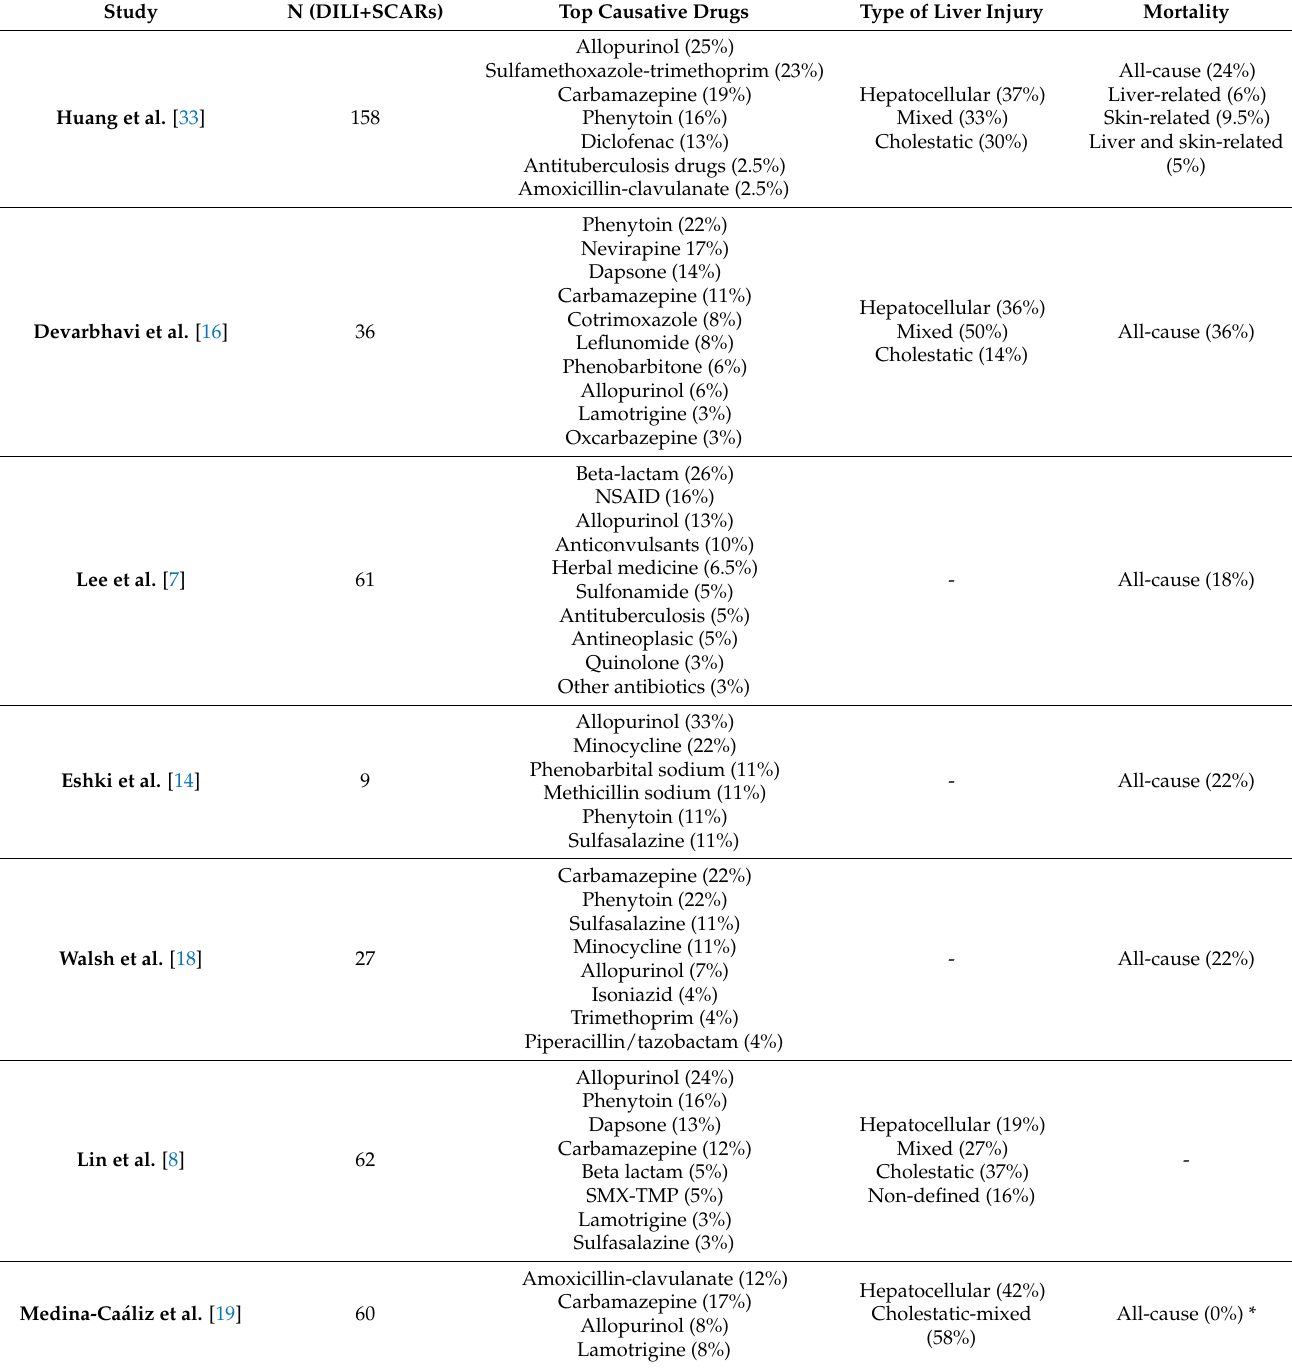
Table 1. Most common culprit drugs for DILI associated with